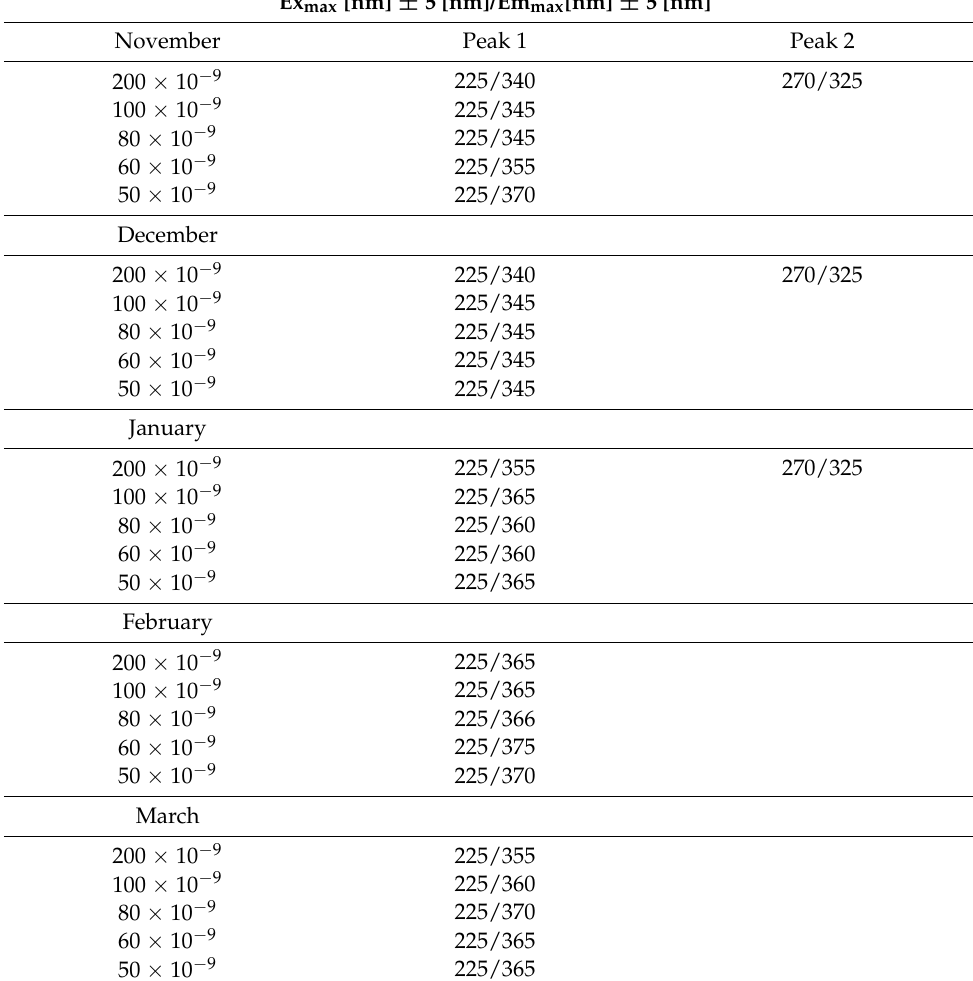
Table 7. Major fluorescence peaks for seawater polluted by a mixture of oils at various r o/w with their wavelength-independent fluorescence maxima ( λ Ex / λ Em ) in the period of November to March